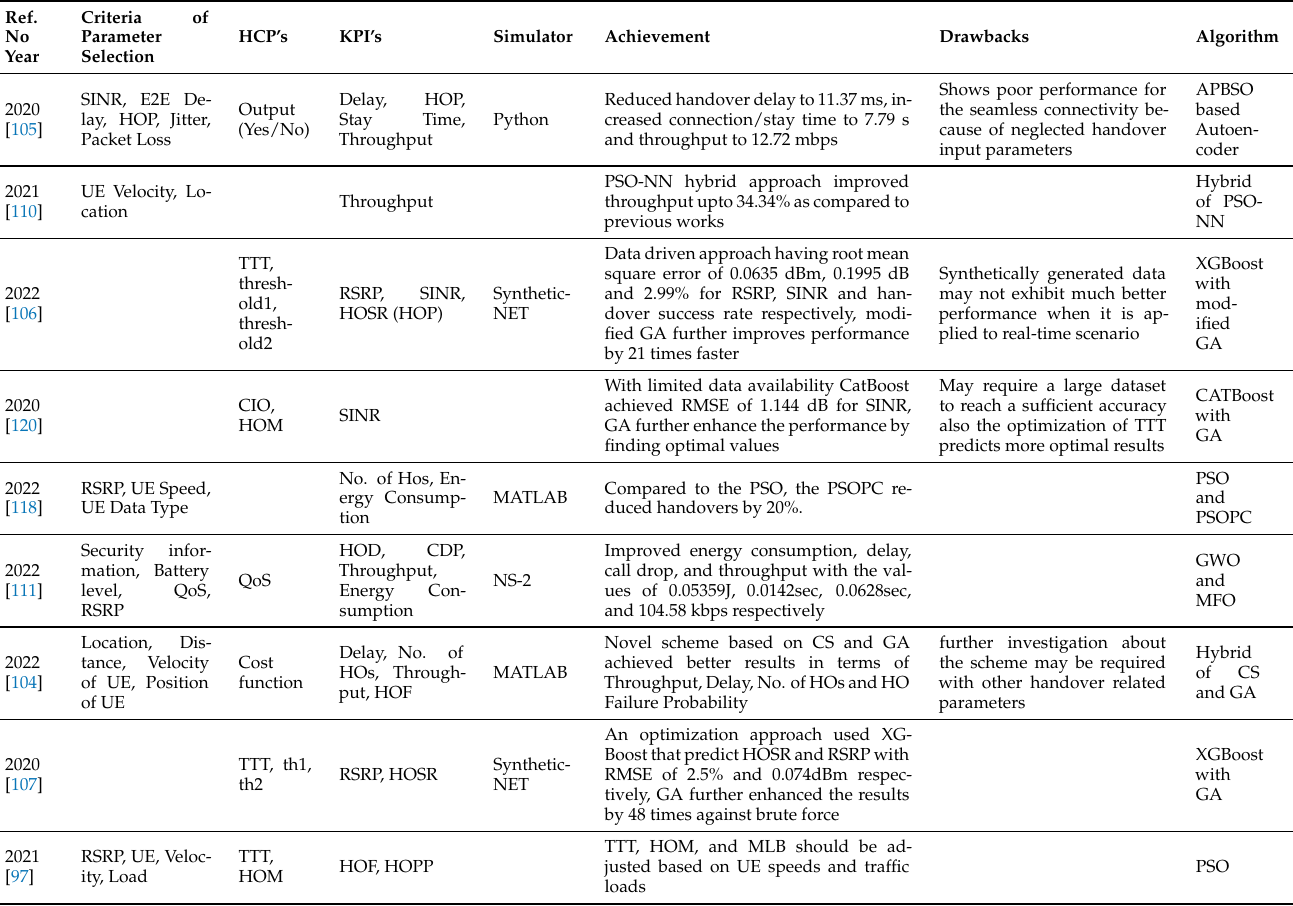
Table 8. Summary of Metaheuristic-based Handover